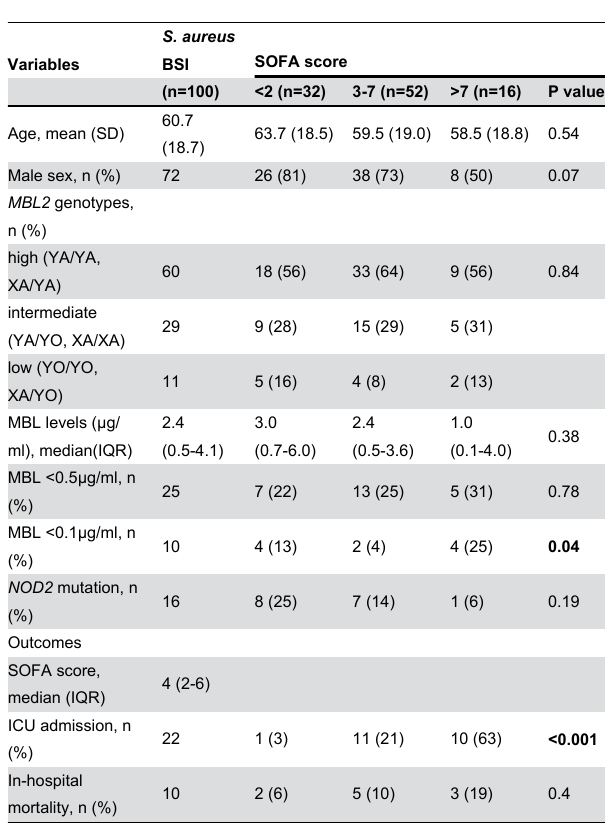
Table 4. Clinical characteristics and outcomes in S. aureus BSI cases